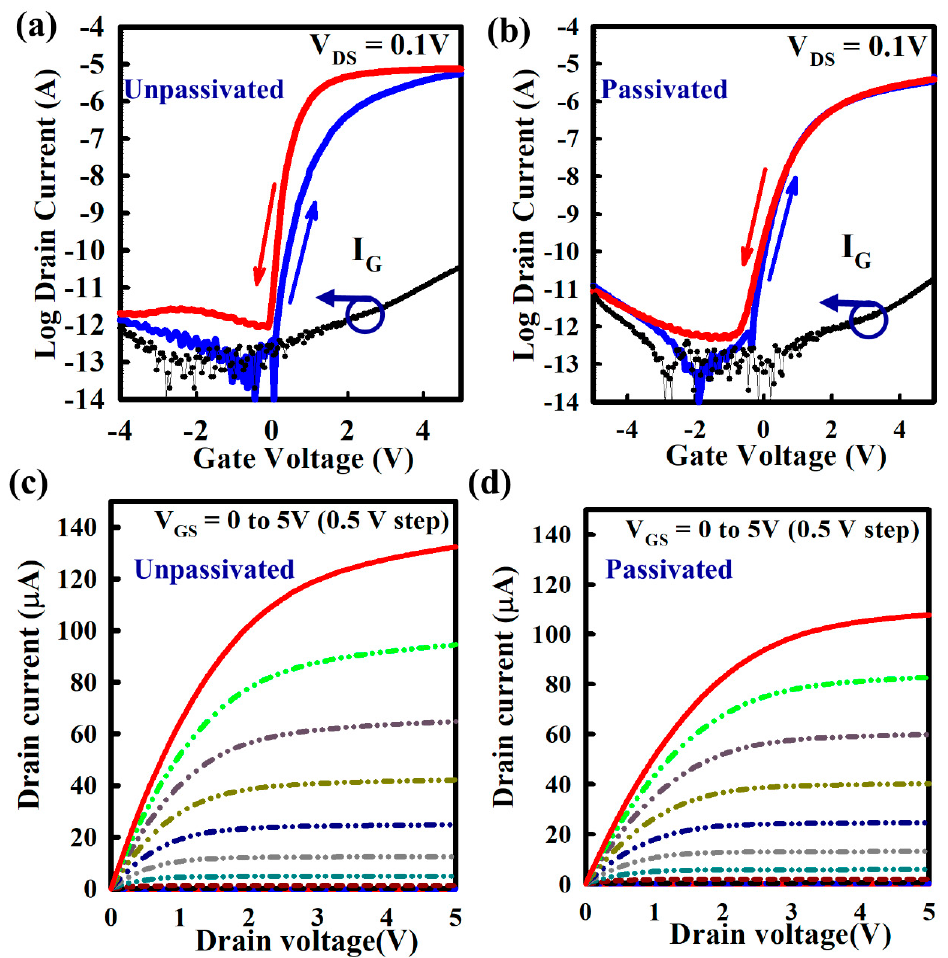
Figure 4. Electrical performance of ZnO TFT without and with Y 2 O 3 passivation by spray pyrolysis. (a, b) Plots of the transfer characteristics with hysteresis and gate leakage currents (I G ) as a function of V GS for ( a ) without and ( b ) with Y 2 O 3 passivation. ( c and d ) Output curves of ZnO ( c ) without and ( d ) with Y 2 O 3 passivation. The hysteresis voltage of the thin film transistor (TFT) was taken at I DS = 10 − 10 A with forward sweep from − 5 to +5 V and reverse sweep from +5 to − 5 V at the same drain voltage (V DS = 0.1 V). Output curves were measured by varying V GS from 0 to +5 V with a 0.5 V step.